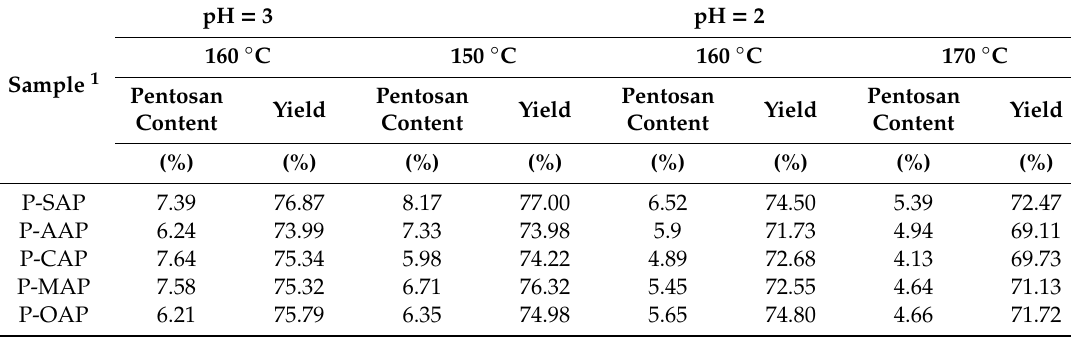
Table 2. Pre-experimental